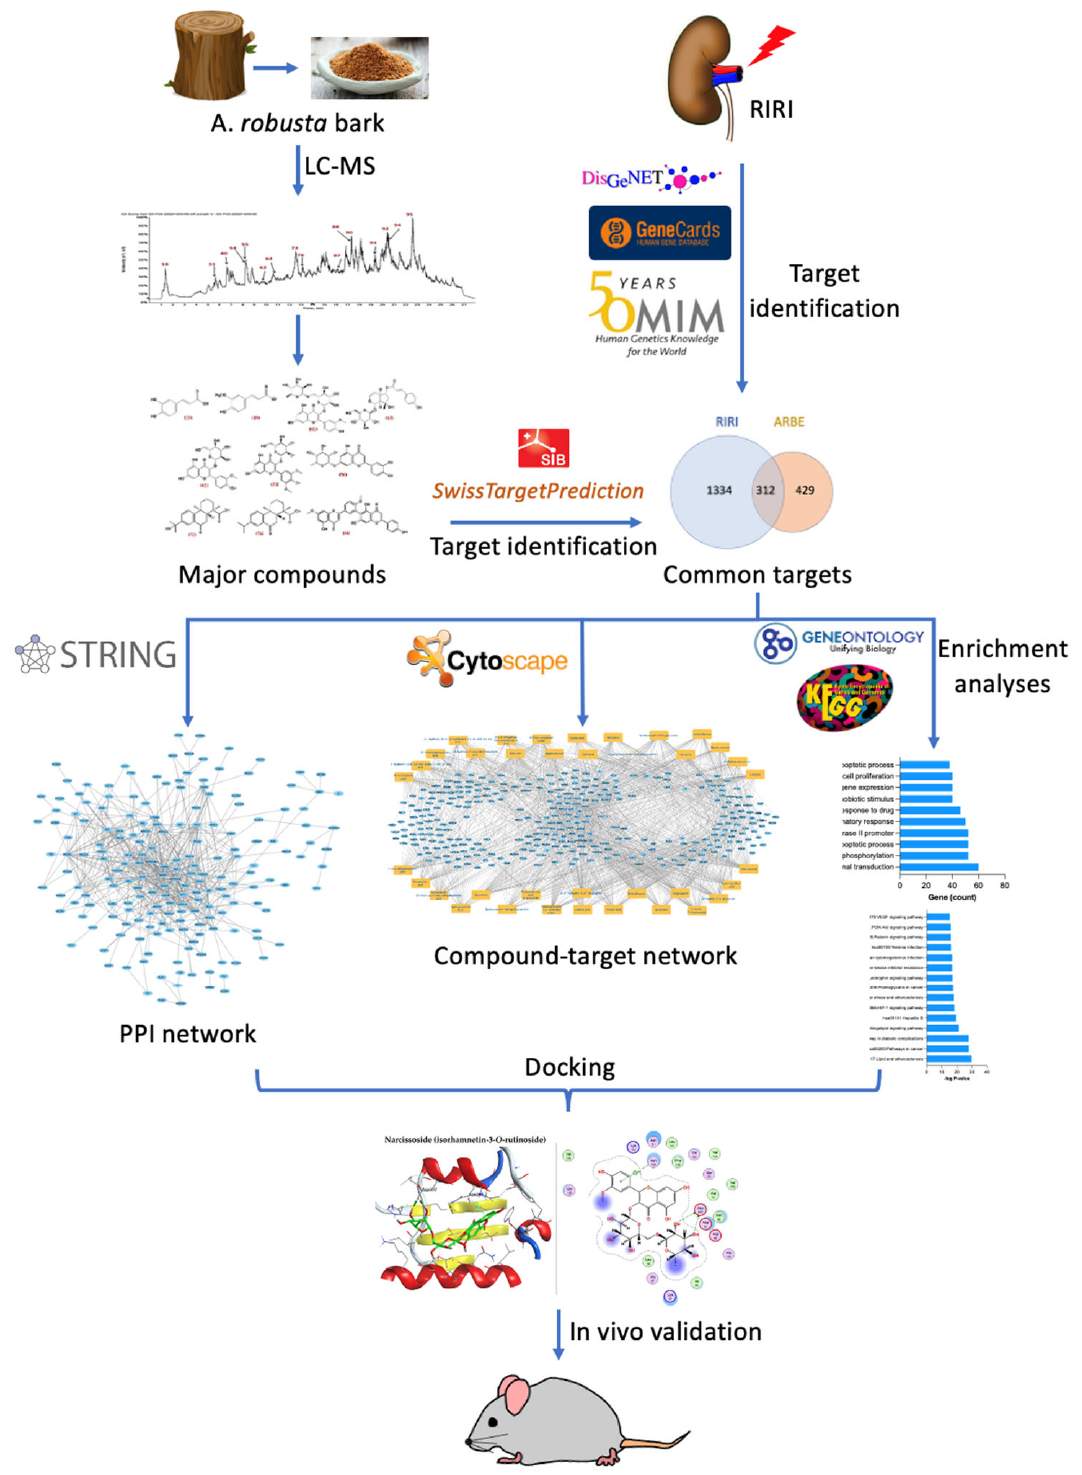
Figure 1. Flowchart of the workflow showing the experimental design of this study, including phytochemical, network pharmacological, and experimental studies for the investigation of the effect of ARBE in